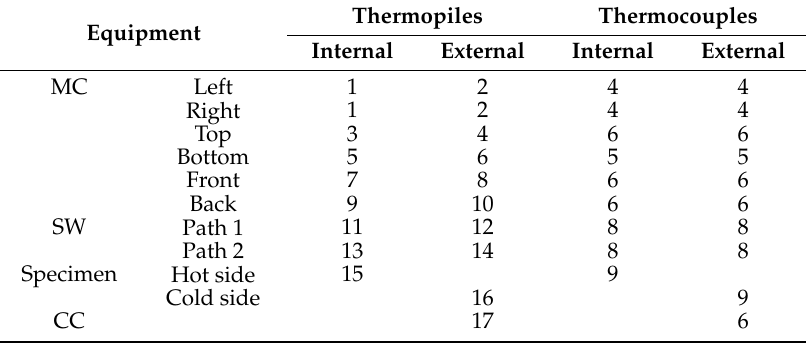
Table 4. Thermopiles and thermocouples